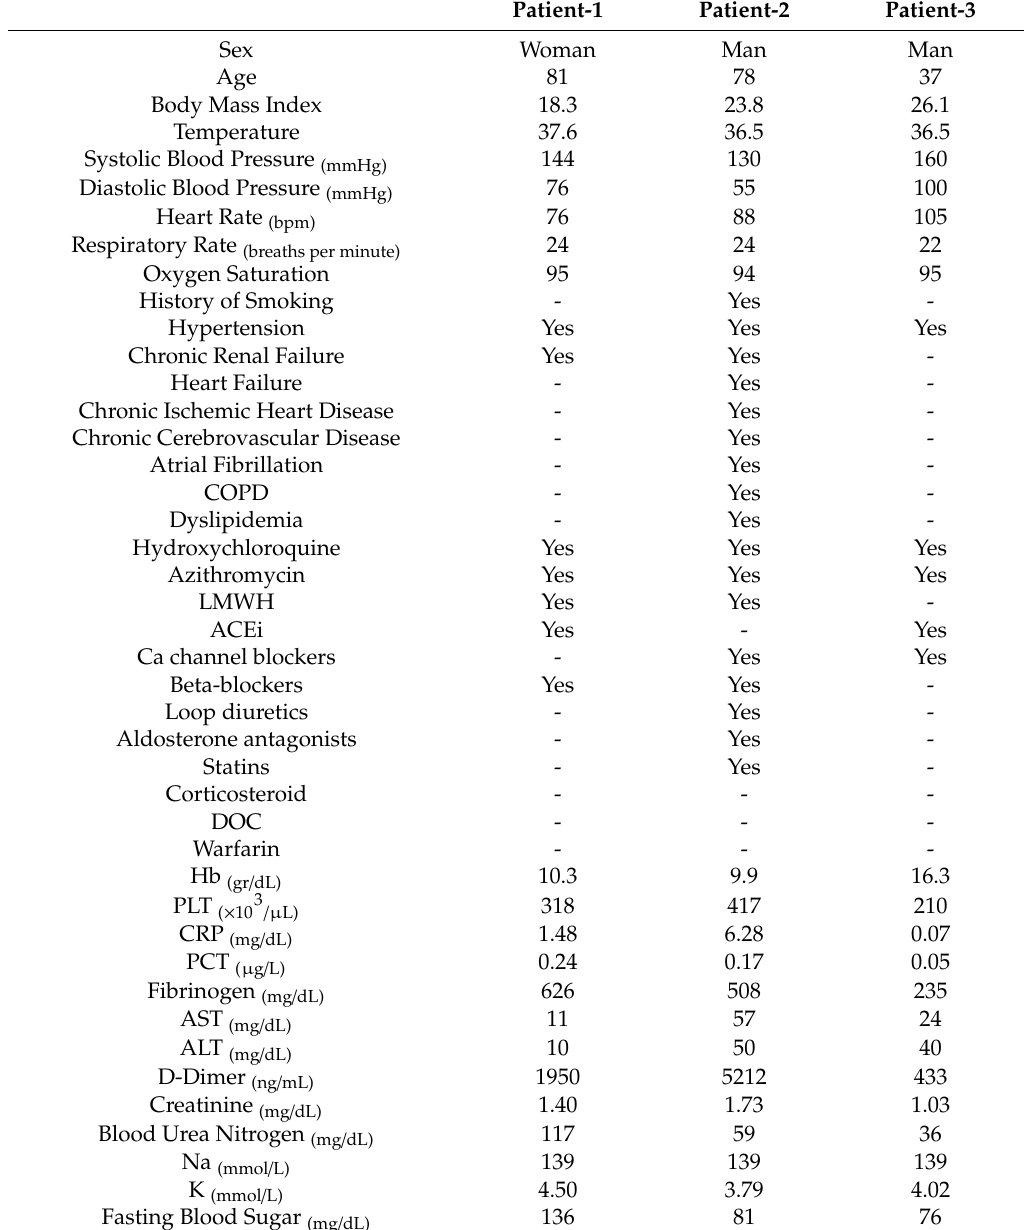
Table 1. Clinical and laboratory variables of the three